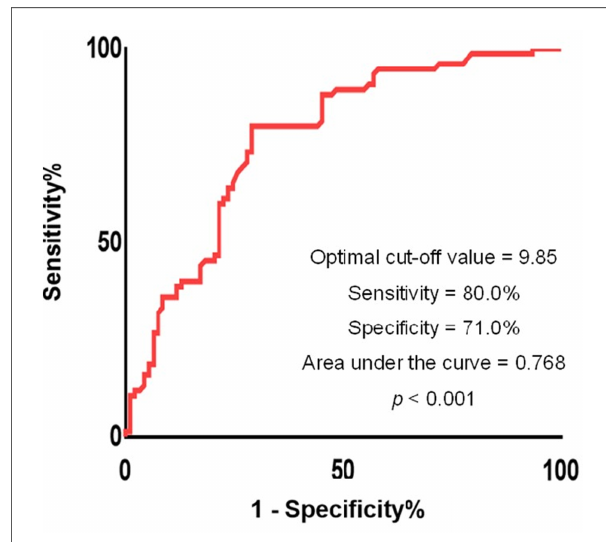
FIGURE 2 Receiver operating characteristics curves of the proposed predictive model. The optimal threshold of the model for predicting left ventricular recovery was − 0.57 with sensitivity 0.800, speci fi city 0.710, and area under the curve 0.768, respectively ( p <0.001).